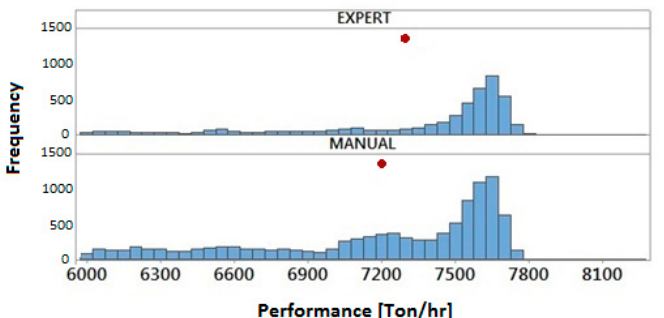
Figure 3. Data Rate: Expert System vs. Manual Operation.